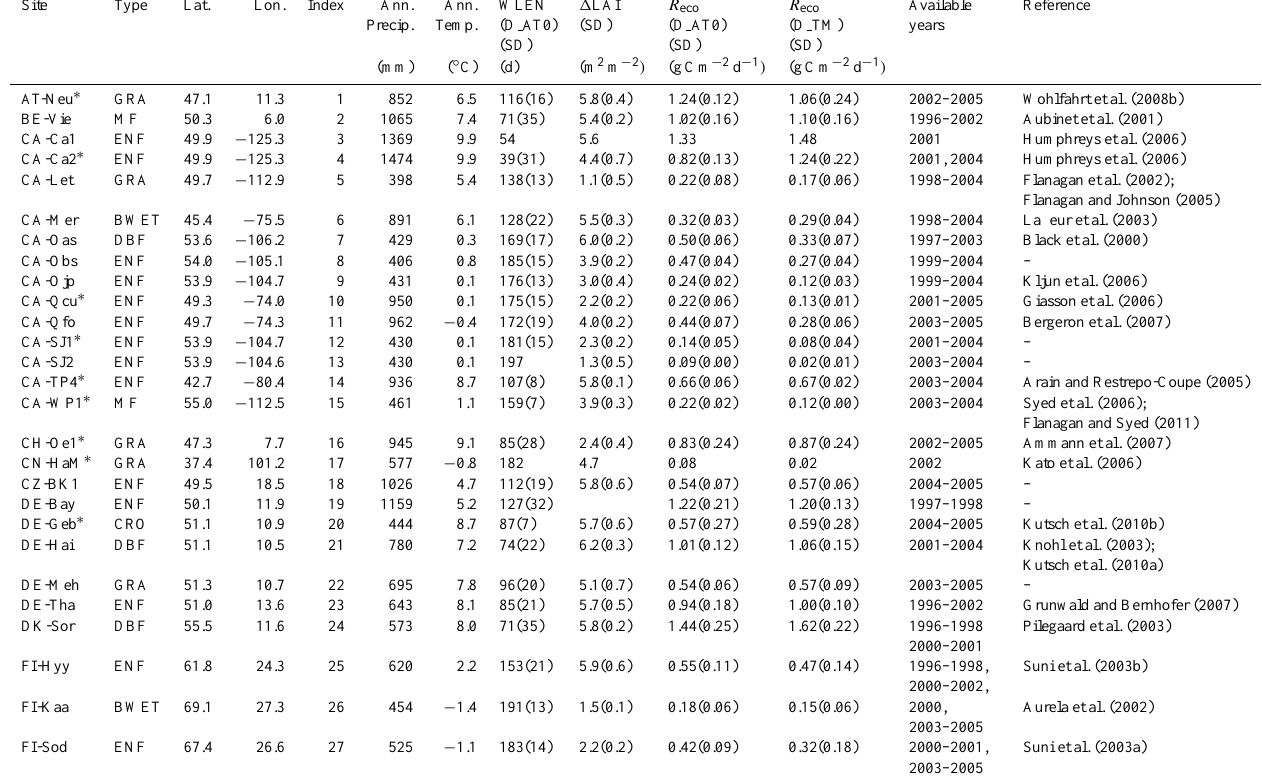
Table 1. General characterization of study sites used in this